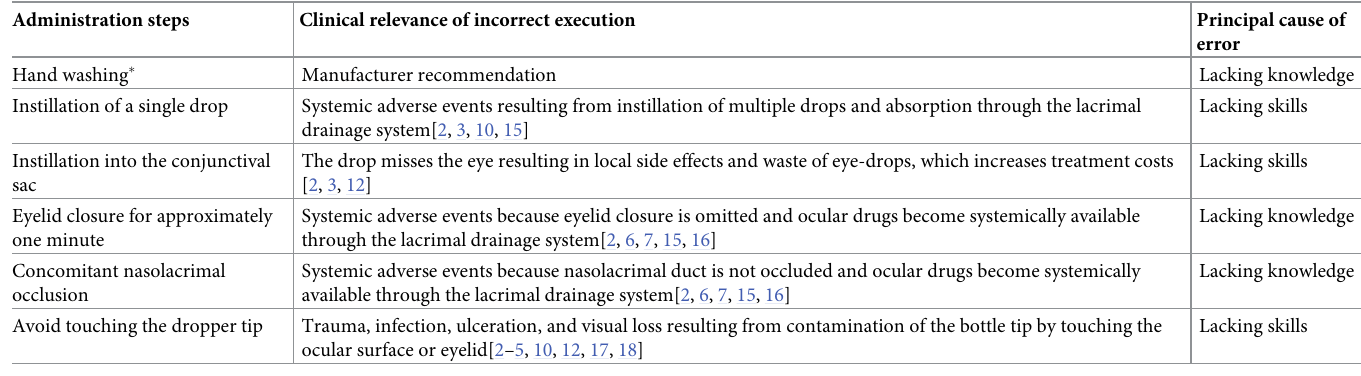
Table 1. Clinically relevant steps in the eye-drop administration